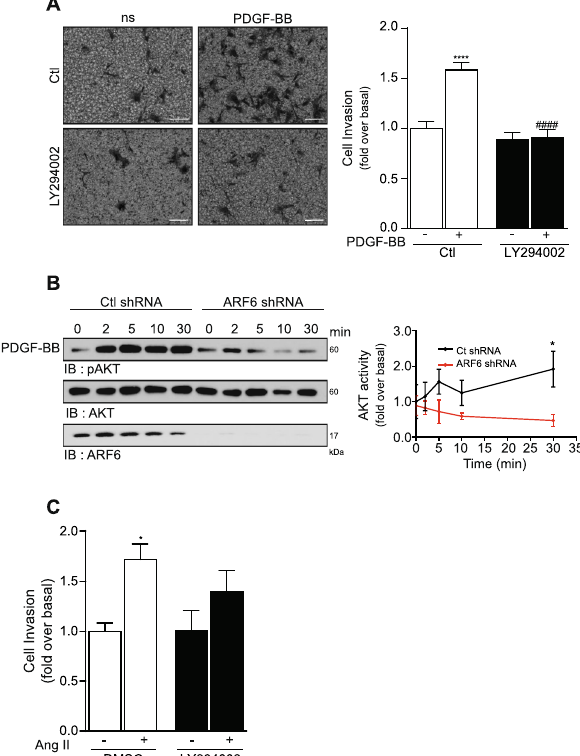
Figure 5. Activation of the PI3K pathway by ARF6 is important for PDGF-BB-mediated invasion. ( A ) 100 000 HASMC cells were seeded into Matrigel-coated Boyden chambers and pretreated with DMSO (Ctl) or LY294002 (25 µM) for 1 h. One set of cells was left untreated (non-stimulated; ns) and the other was stimulated with PDGF-BB (25 ng/mL) for 24 h. Images are from the lower part of the membrane and are representative of five images taken per condition. Quantifications are the mean ± SEM realised on six independent experiments. ****P < 0.0001 are values compared to basal condition, #### P < 0.0001 compared to Ctl PDGF-BB (Two- Way Anova) (bar = 100 µm). ( B ) Cells were infected with a Ctl or ARF6 shRNA and then serum starved 16 h before stimulation with 25 ng/mL of PDGF-BB for 0, 2, 5, 10 and 30 min. Cells were lysed and AKT activity was assessed by Western blotting using specific antibodies. Quantifications are the mean ± S.E.M. of three independent experiments. *P < 0.05 (Two-Way Anova). ( C ) Cells were seeded and pretreated as in ( A ). One set of cells was left untreated and the other was stimulated with Ang II (100 nM) for 24 h. Quantifications are the mean ± SEM of five independent experiments. *P < 0.05 are values compared to basal condition (Two-Way